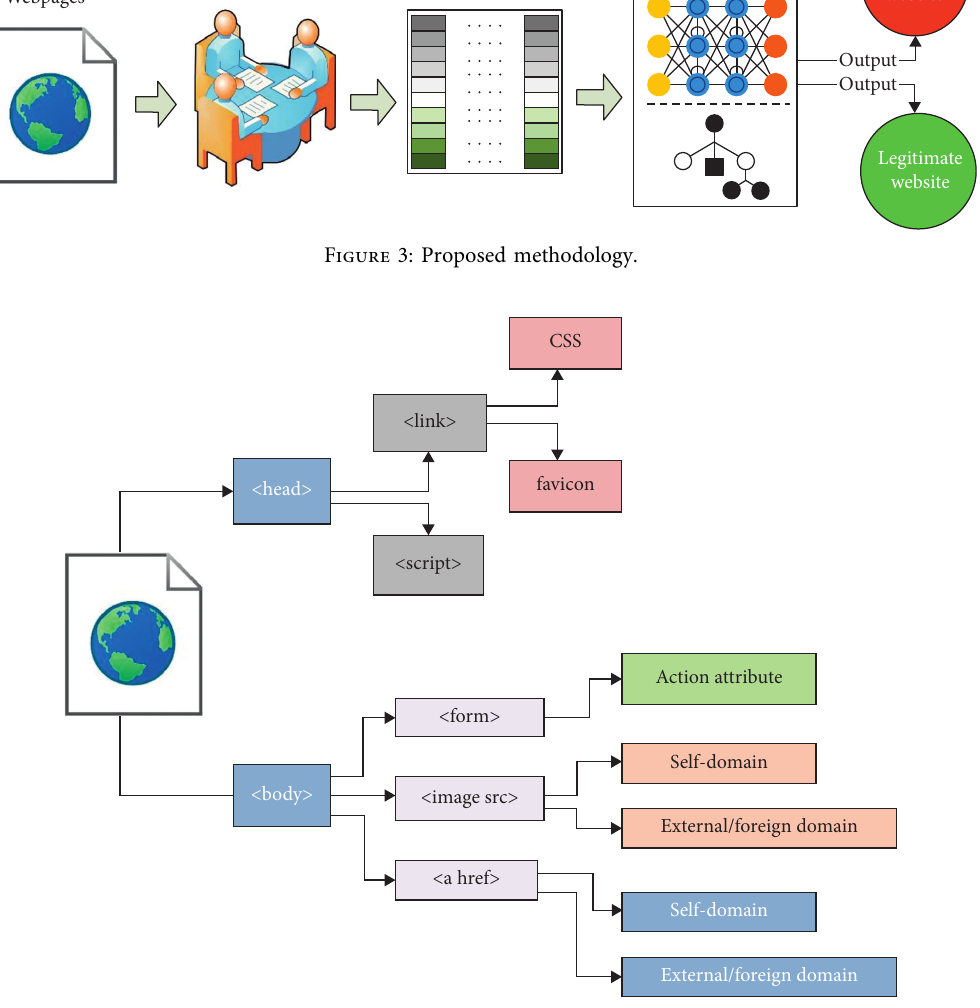
Figure 4: Hyperlink feature extraction process. Table 1: LSTM model